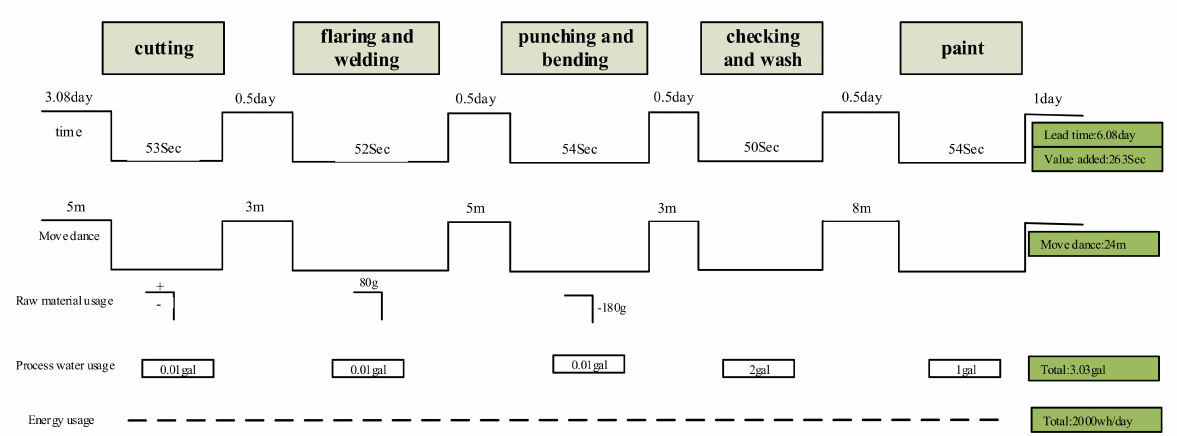
Figure 9. Resource consumption of satellite dish kit production line (after